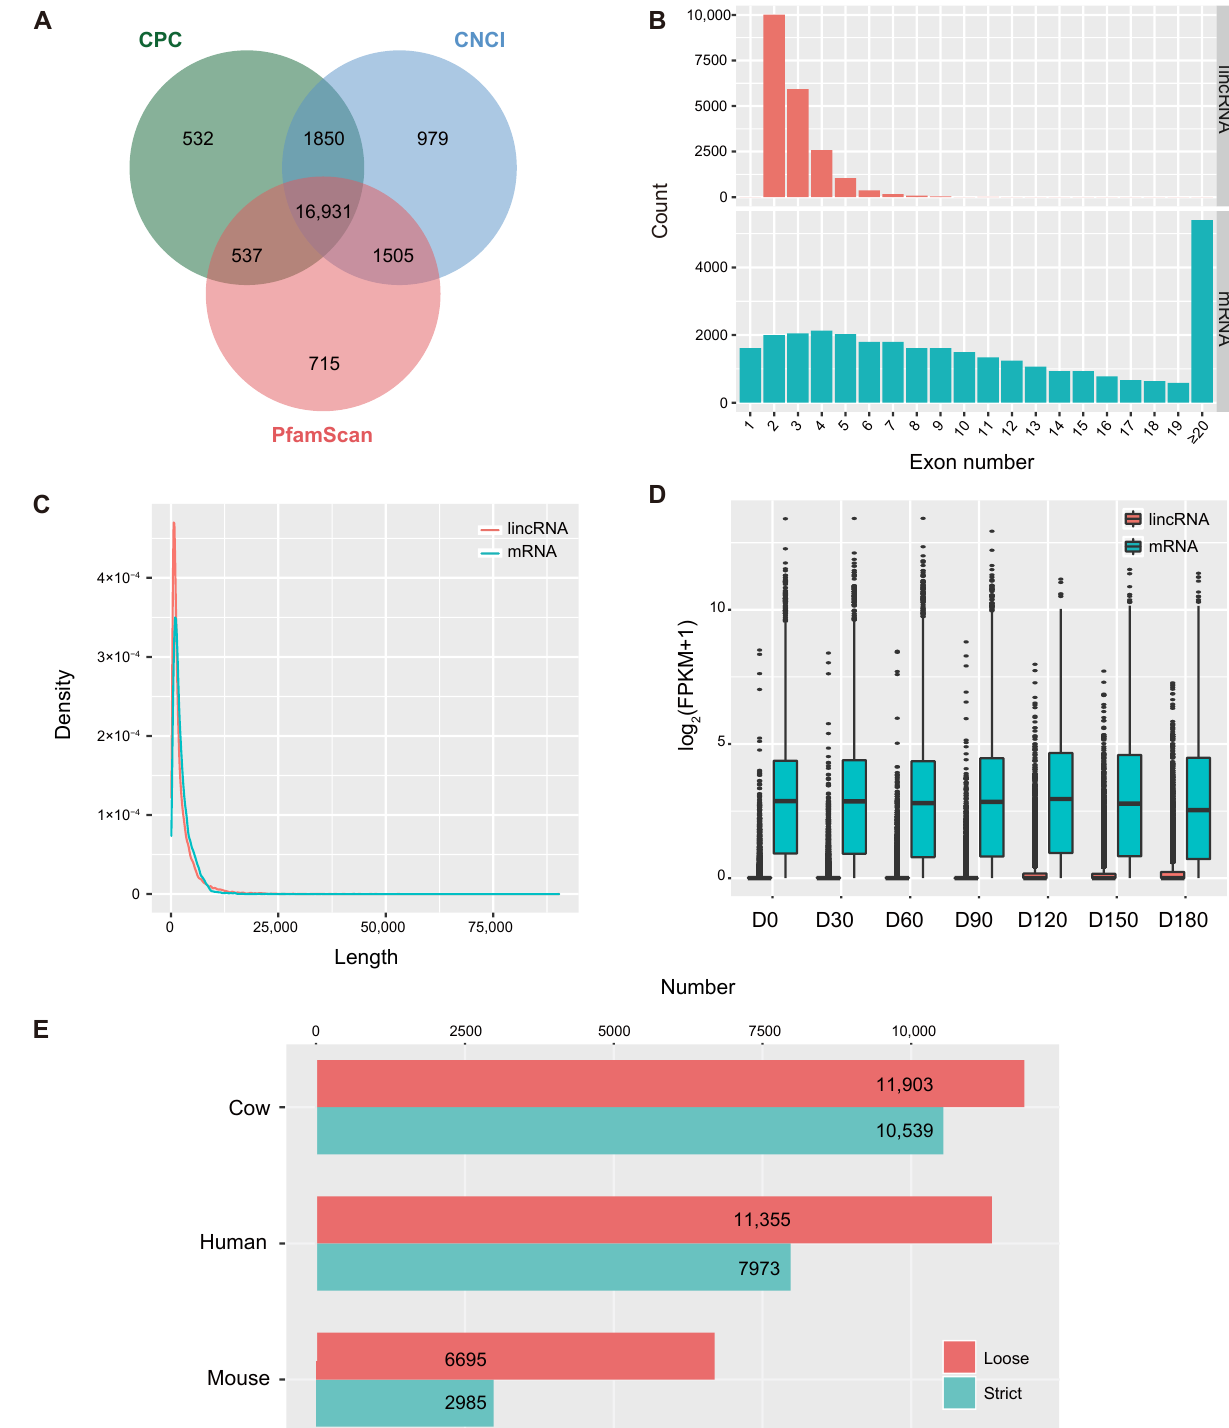
Figure 1. Identification of long intergenic non-coding RNAs (lincRNAs). ( A ) Identification of the coding potential of transcripts using CNCI, CPC and PfamScan. ( B ) Compared with mRNAs, lincRNAs had fewer exons. ( C ) Compared with the mRNAs, the lincRNAs were shorter. ( D ) Transcriptional levels of lincRNAs and mRNAs. The transcription levels of lincRNAs and mRNAs at each age are represented by the mean value of the three individuals. ( E ) Number of goat testicular lincRNAs that are homologous to NONCODE lincRNAs in the cow, human, and mouse with a loose (E-value < 1 × 10 − 3 ) and strict (E-value < 1 × 10 − 10 ) threshold by